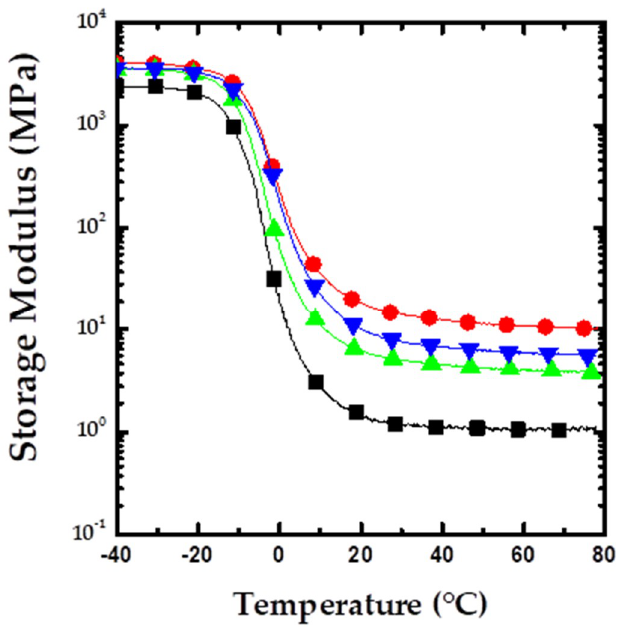
Figure 1. Storage modulus (E’) vs. temperature for a) reference material V-SBR-REF-0 ( ■ —black line), line), vulcanized sepiolite S9/SBR nanocomposite (V-SepS9/SBR, • —red line), vulcanized nano sized vulcanized sepiolite S9/SBR nanocomposite (V-SepS9/SBR, ●—red line), vulcanized nano sized sepiolite S9/SBR nanocomposite (V-NS-SepS9/SBR, (cid:78) —green line), and vulcanized nano sized and sepiolite S9/SBR nanocomposite (V-NS-SepS9/SBR, ▲ —green line), and vulcanized nano sized and silanized sepiolite S9/SBR nanocomposite V-NS-SilSepS9/SBR ( (cid:72) —blue silanized sepiolite S9/SBR nanocomposite V-NS-SilSepS9/SBR ( ▼ —blue line).